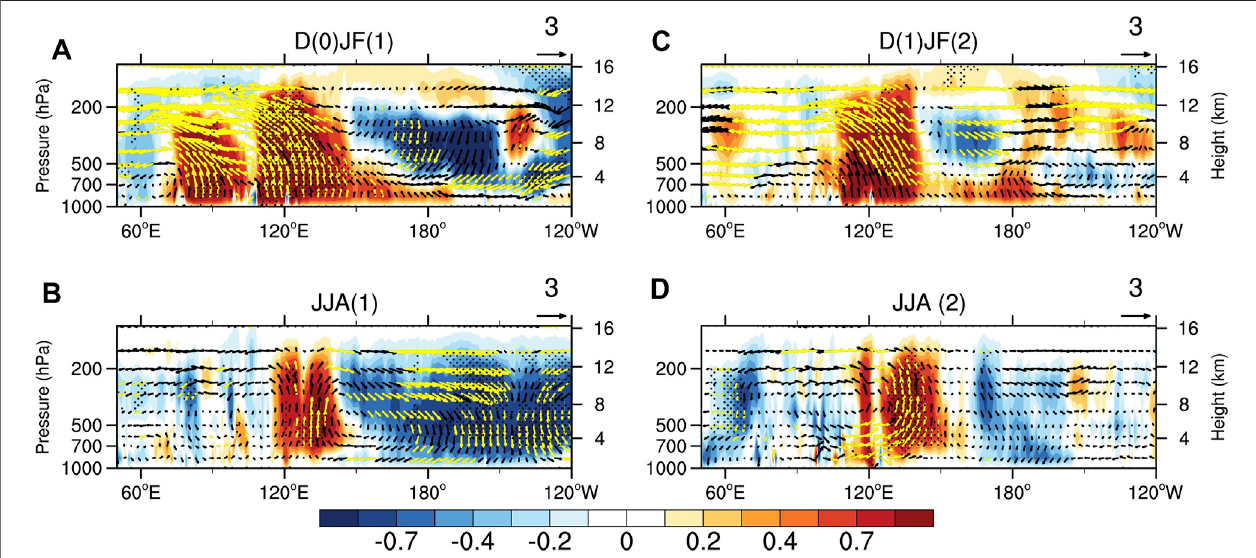
FIGURE7| Compositesofanomalouszonalcirculationoverthenorthernhemispherictropicalregion(5 – 20 ° N)withspeedintheverticaldirection(shaded,units:m/ s) and zonal vertical velocity (vector, units: m/s) during (A) D (0) JF (1), (B) JJA (1), (C) D (1) JF (2), and (D) JJA (2). Dotted areas and yellow vectors indicate values exceeding the 90% con fi dence level determined using a two-tailed Student ’ s t